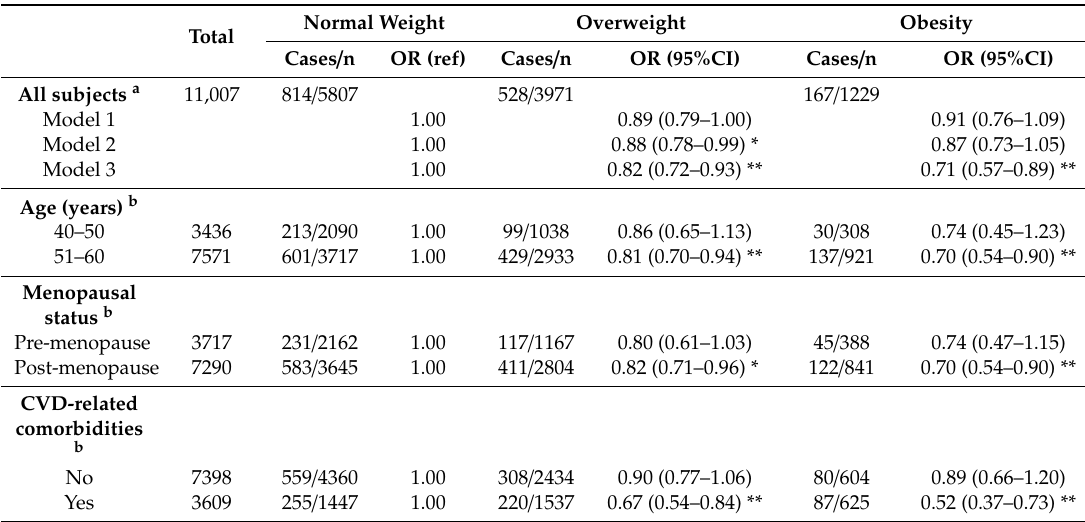
Table 3. Odds ratios (ORs) and 95% confidence internals (CIs) for HHcy associated with body mass